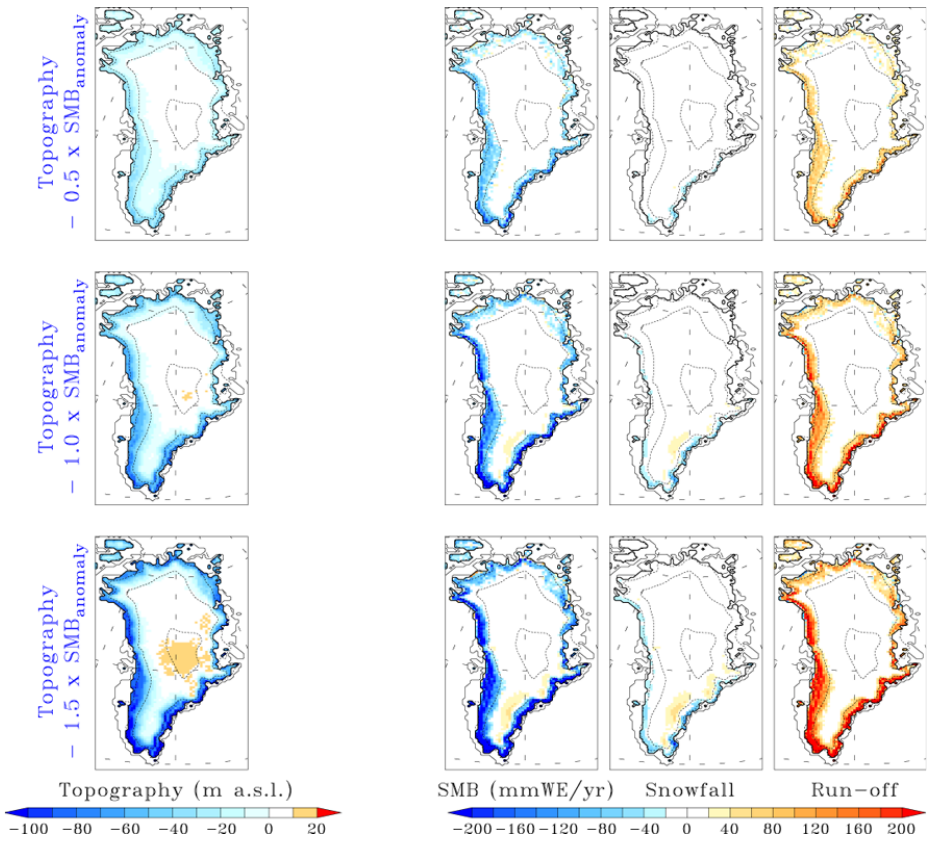
Fig. 8. (Left) Difference of surface elevation (in m a.s.l.) between the control run and the three sensitivity experiments. The ice sheet topography used in the sensitivity experiments is the control run topography plus 0.5, 1.0 and 1.5 times the cumulated surface height anomaly from 2000–2080 SMB changes simulated by MAR MIROC5 (RCP85) using a fixed topography. (Right) Difference over 2080–2099 of the mean annual SMB, run-off and snowfall in mmWE/yr between the three sensitivity experiments and the control